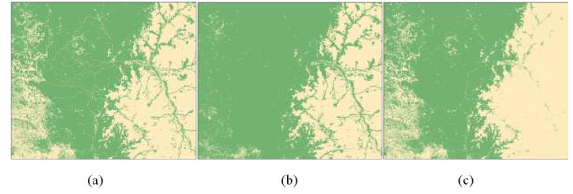
Figure 3: Comparison of (a) the national forest cover map, (b) the Global Forest Cover based forest cover map with a 30% tree cover threshold and (c) the Global Forest Cover based forest cover map with a 70% tree cover threshold over a 100 x 80 km extract in Eastern Gabon (Source Sannier et al, 2016) Unbiased area